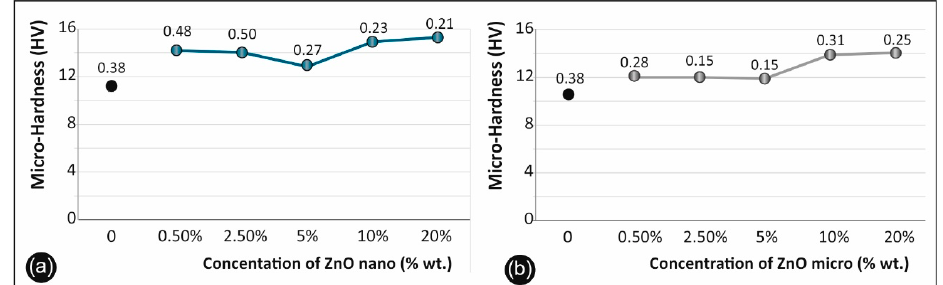
Figure 11. Micro-Hardness Vickers results of ABS/ZnO nanocomposites ( a ) and micro-composites ( b ) versus the filler concentration (numbers in the graph points indicate the calculated deviation for each value).